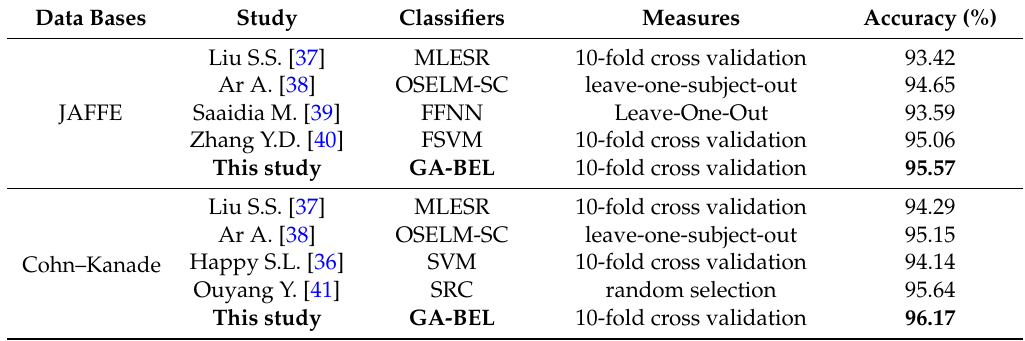
Table 9. Classification accuracies obtained with the proposed method and other